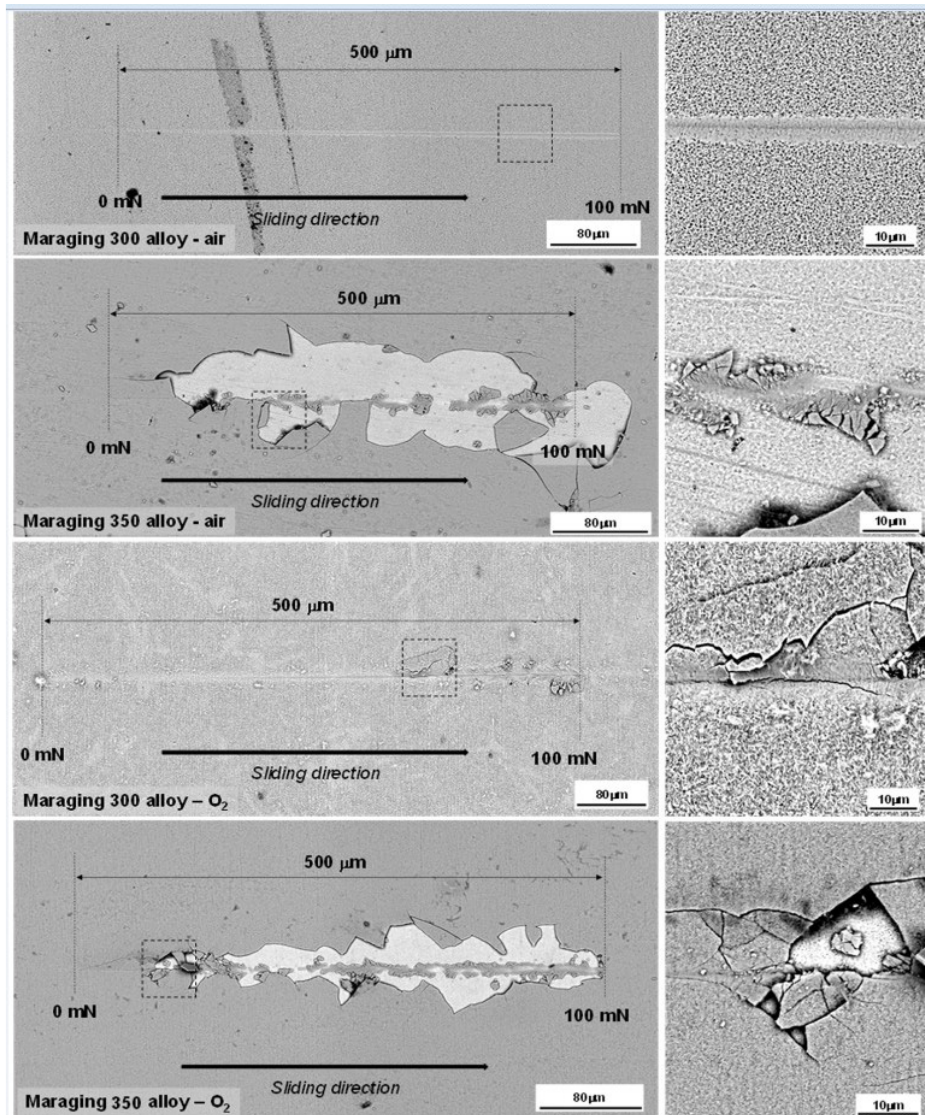
Figure 14. FE-SEM (left-hand side) image for the nanoscratch track and (right) magnification of the top-view FE-SEM images of nanoscratch tracks (made on each oxide produced on the steel and treatment described on left-side image) where the first adhesive damage